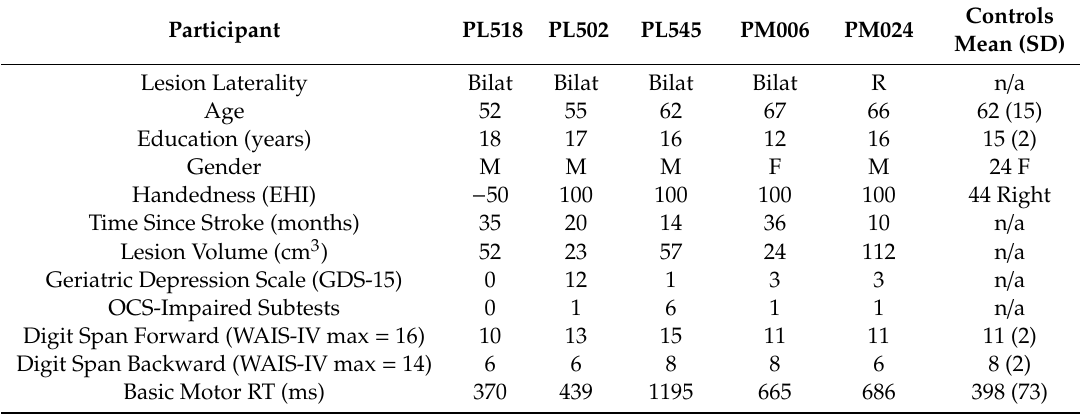
Table 1. Demographic and lesion information for the five included patients and controls, and scores on basic tests. Handedness was measured by the short form of the Edinburgh Handedness Inventory (EHI) [41]; depression was measured with the short version of the Geriatric Depression Scale (GDS- 15 [42]). General cognition was screened with the Oxford Cognitive Screen (OCS) [43], and the number of impaired subtests are listed. Digit span forward and backward was measured with the WAIS-IV UK [44] and total scores are listed. Basic motor reaction time (RT) was measured by responding to a